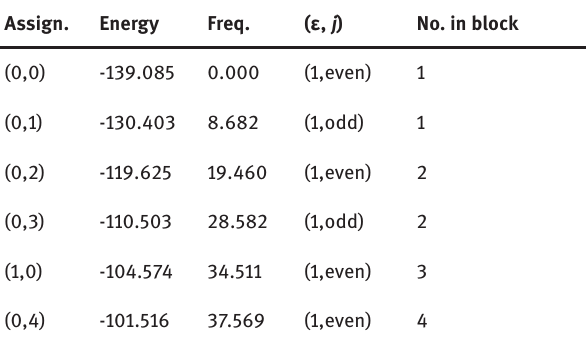
Table 3: The intermolecular vibrational energy levels (in cm -1 ) and assignments (nstretch, nbend) for T-shaped isomer of the C complex.